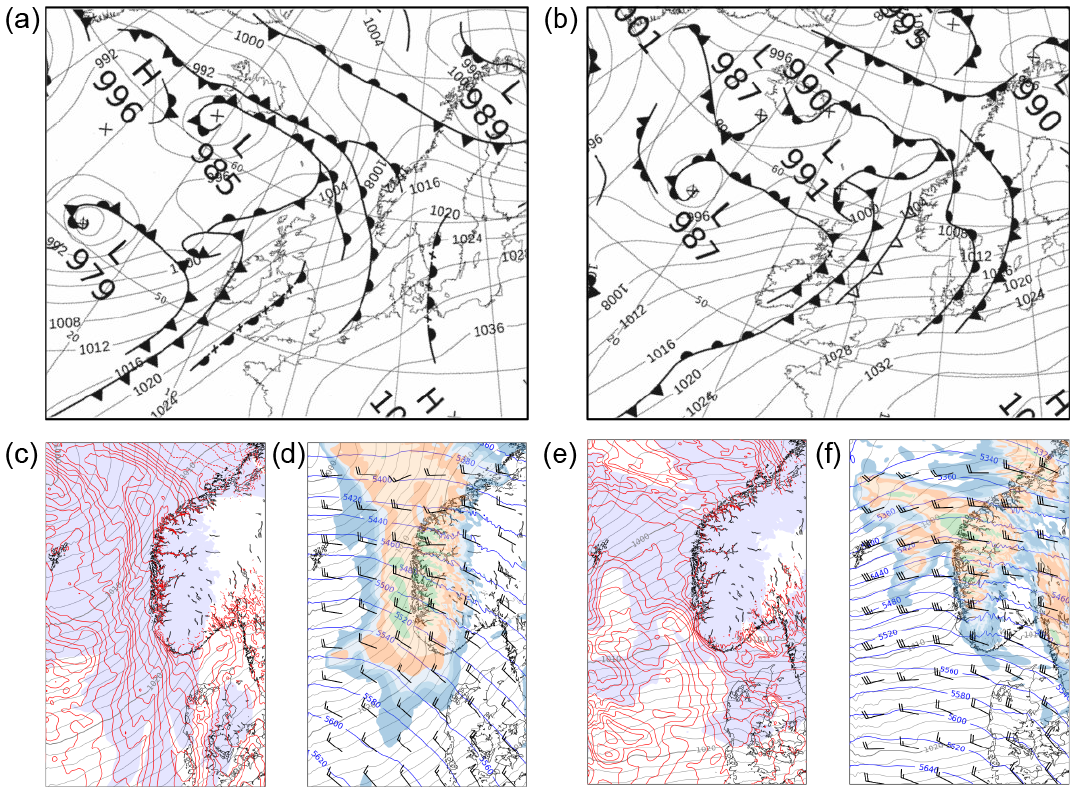
Figure 2. Overview of frontal structures during the precipitation event on 7 December 2016. Sea level pressure and surface fronts identified by the UK Met Office at (a) 06:00UTC and (b) 18:00UTC. (c) Sea level pressure (hPa, grey lines), air temperature (K, red lines), and relative humidity above 80% (shaded) at 850hPa at 06:00UTC. (d) Sea level pressure (hPa, grey), 500hPa geopotential height (g . p . m, blue), wind barbs at 500hPa, and 1h accumulated precipitation (mm, shaded) at 06:00UTC. (e) As panel (c) , but at 18:00UTC. (f) As panel (d) but at 18:00UTC. Panels (c) and (d) are from the 12h MEPS forecast initialized at 18:00UTC on 6 December 2016. Panels (e) and (f) are from the 6h MEPS forecast initialized at 12:00UTC on 7 December